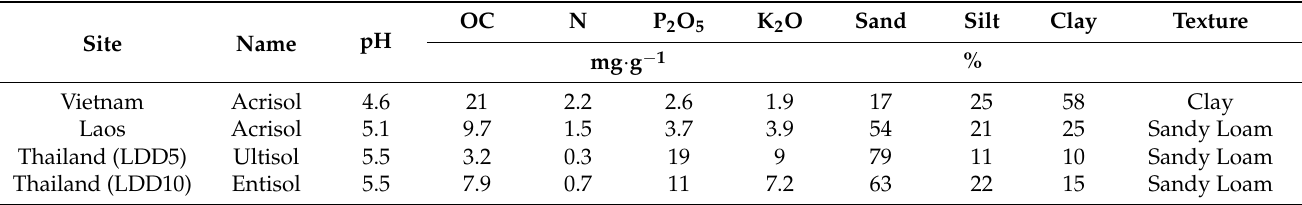
Table 1. Surface soil pH, OC, N, P 2 O 2 and K 2 O contents (mg · g − 1 ) and texture (%) at the beginning of the experiments at all four study sites. Site